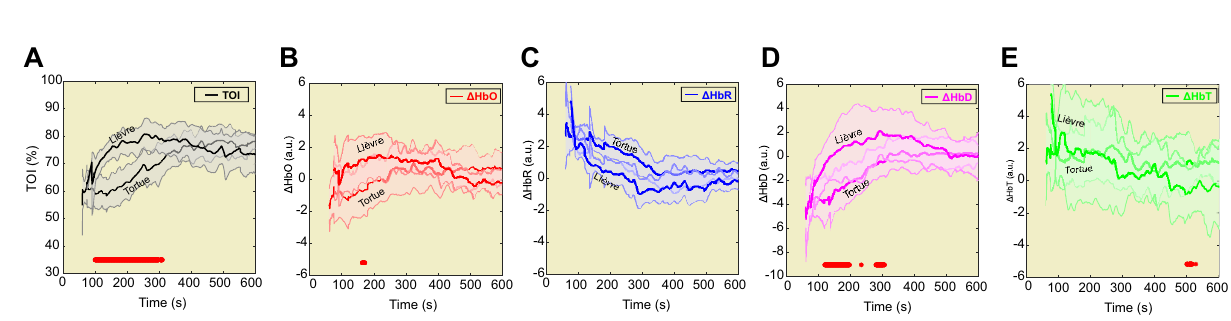
Figure 4. The hemodynamic parameters TOI, [ΔHbO], [ΔHbR], [ΔHbD], and [ΔHbT] are separately presented for each cluster in panels ( A ) to ( E ), respectively. The red bar shows the time window in which the difference between the two clusters was verified to be significant ( p <